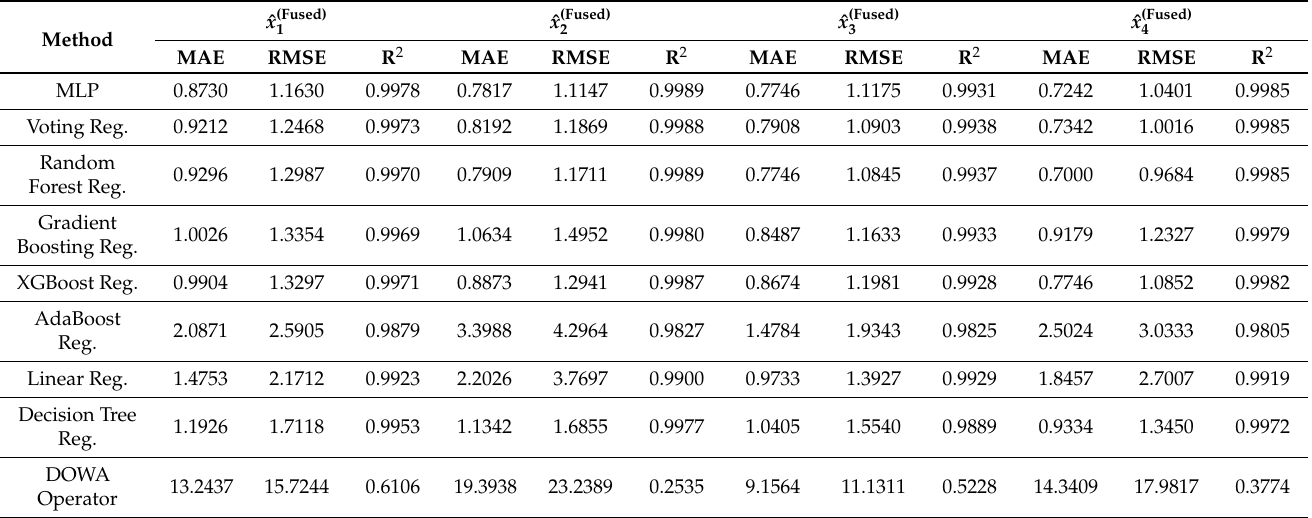
Table 3. Estimation fusion errors on the test